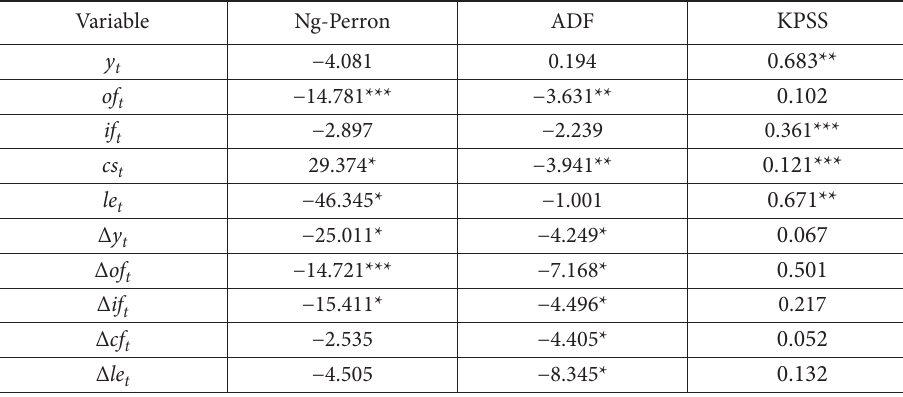
Table 1. Unit root test